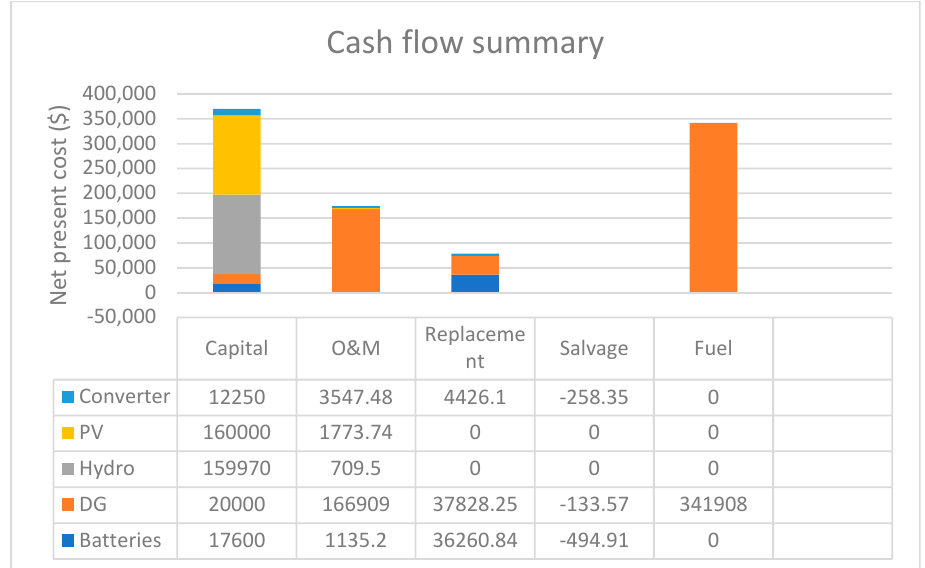
Figure 11. Cash flow summary of PV/hydro/diesel/battery scheme.